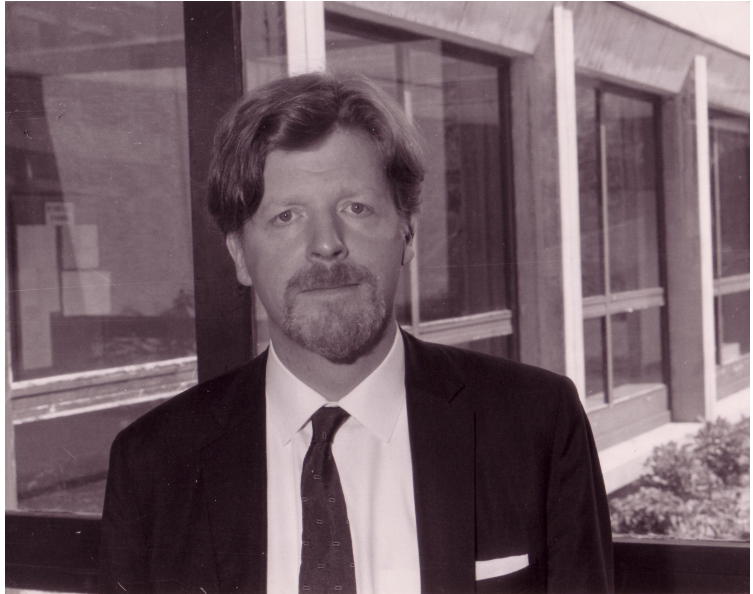
Figure 1. Peter Wynn in 1975. © C.